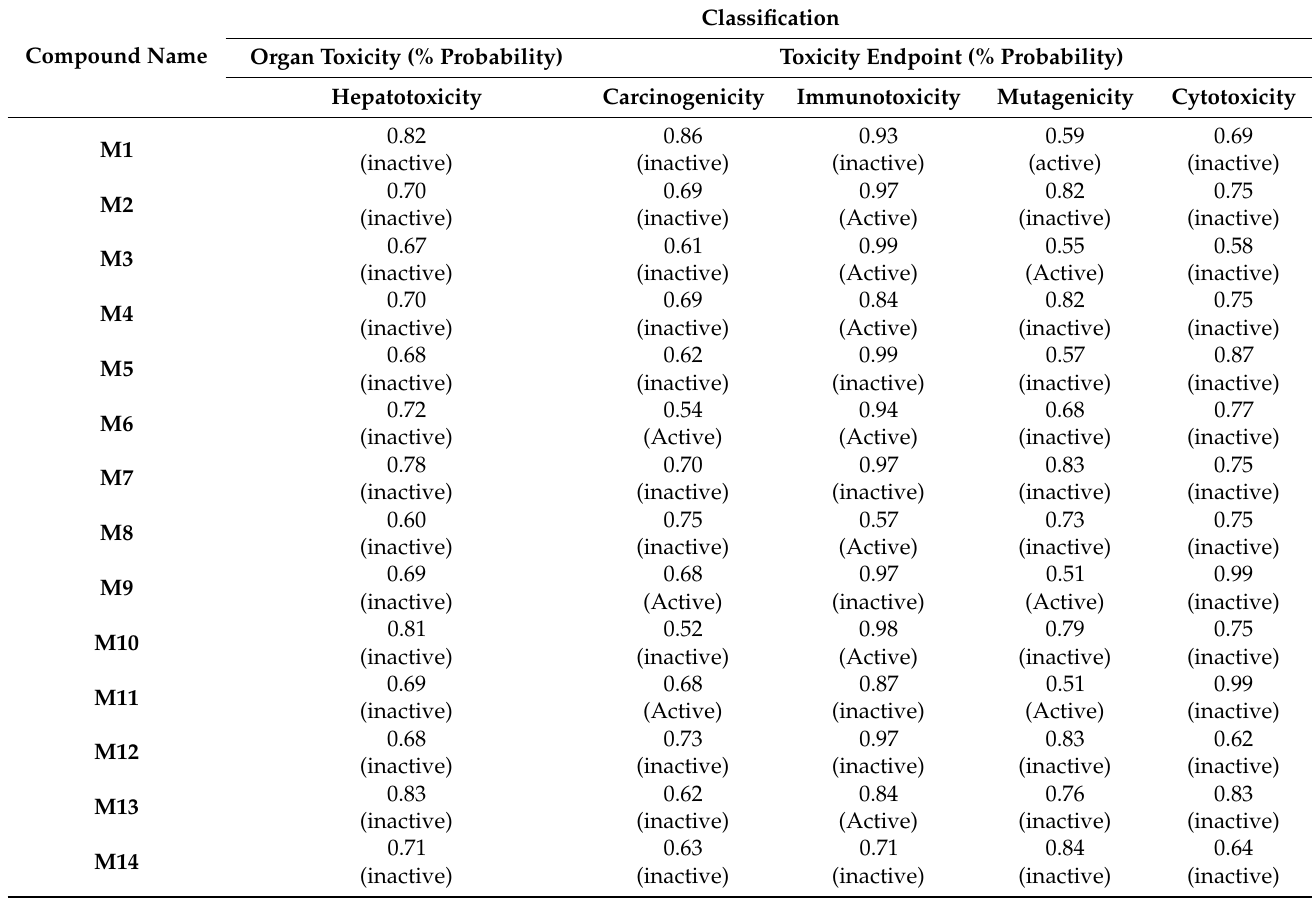
Table 8. Organ and endpoint toxicity predictions of A. fragrantissima flower dichloromethane extract- derived metabolites using the ProTox-II